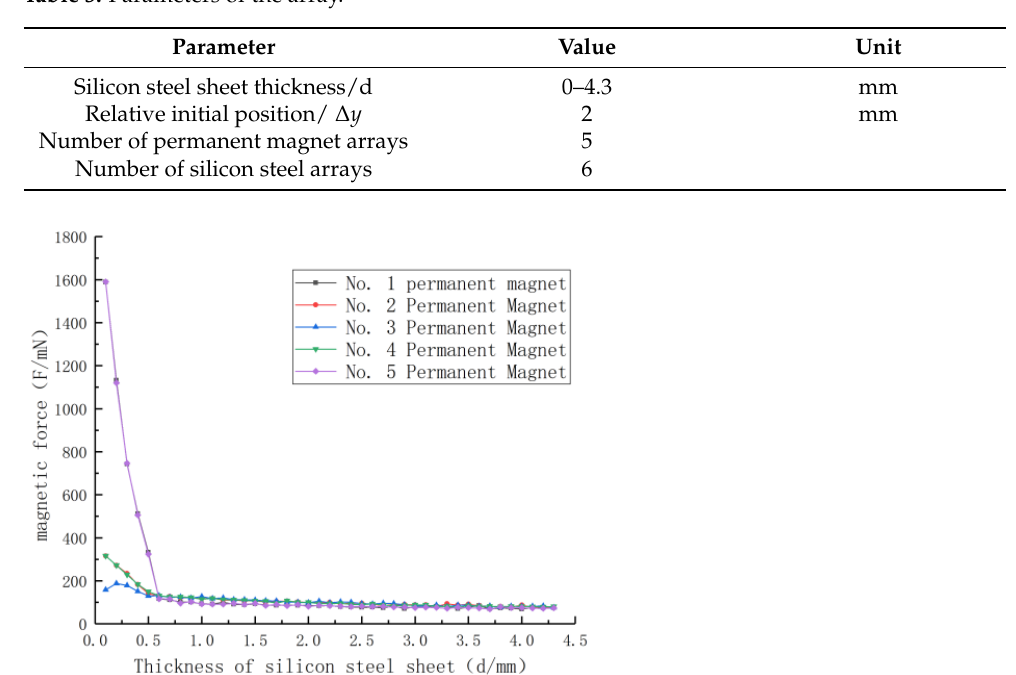
Figure 8. Variation curve of permanent magnet stress with silicon steel thickness.